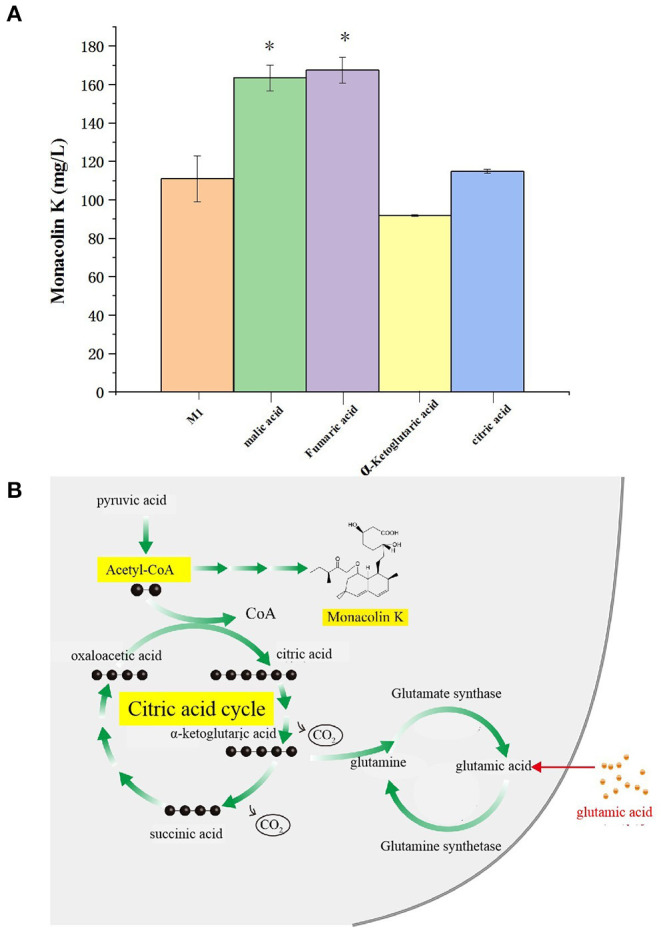
(A) Effect of differential metabolite on the yield of monacolin K (* represents p < 0.05) and (B) schematic diagram to summarize the proposed model for the relationship among the citric acid cycle, acetyl-CoA, monacolin K, and any other metabolites.